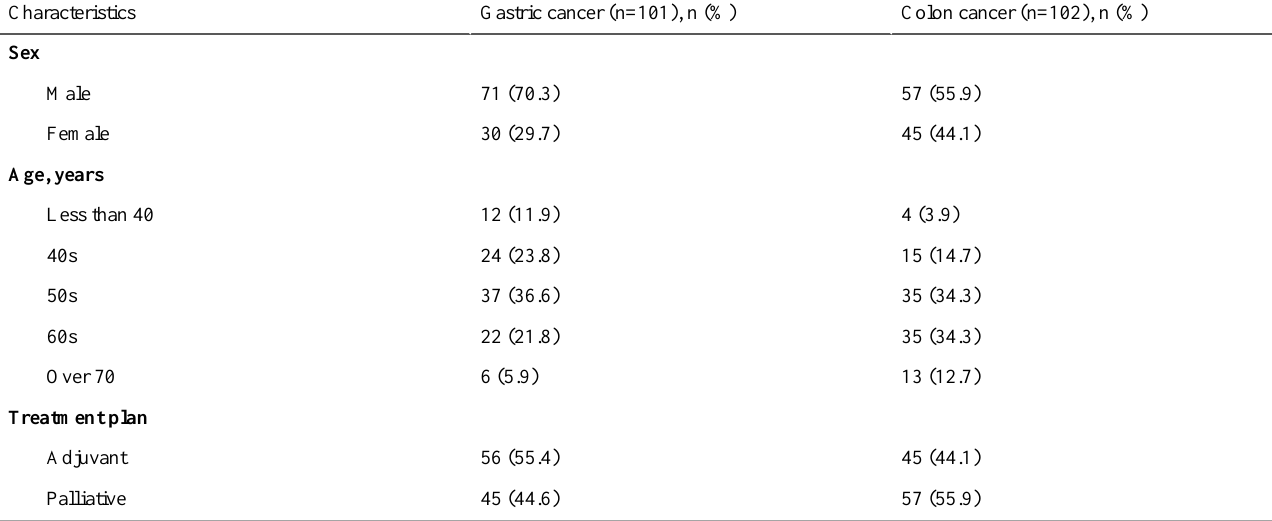
Table 2. Demographic information of study